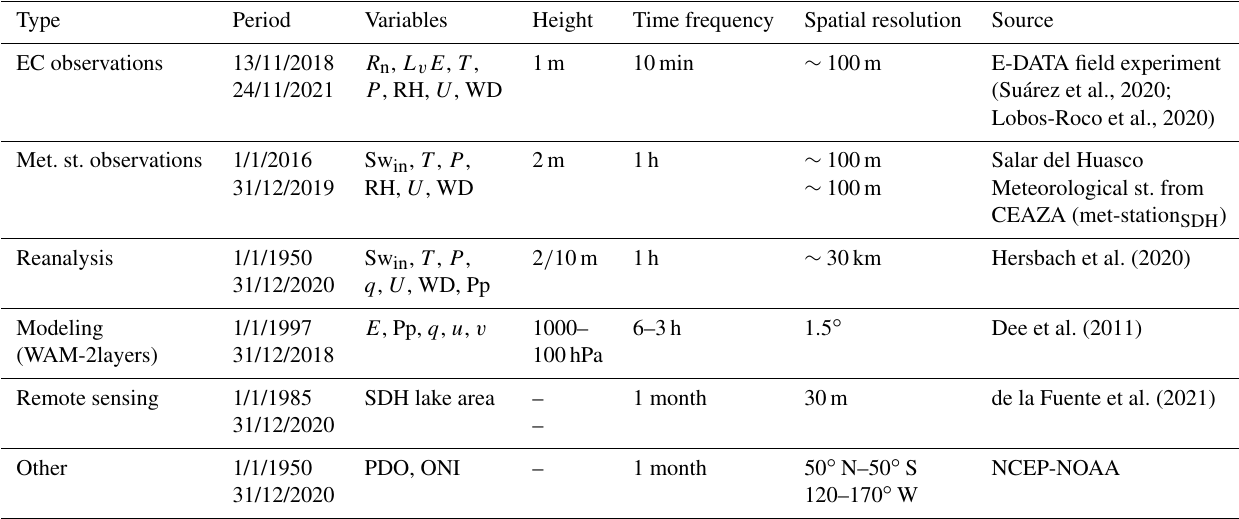
Table 1. Description of the data used in this research. Variables analyzed are incoming shortwave radiation (Sw in ), net radiation ( R n ), latent heat flux ( L v E ), air temperature ( T ), air pressure ( P ), relative humidity (RH), specific humidity ( q ), wind speed ( U ), wind direction (WD), zonal wind ( u ), meridional wind ( v ), Pacific Decadal Oscillation (PDO) and Oceanic El Niño Index (ONI).